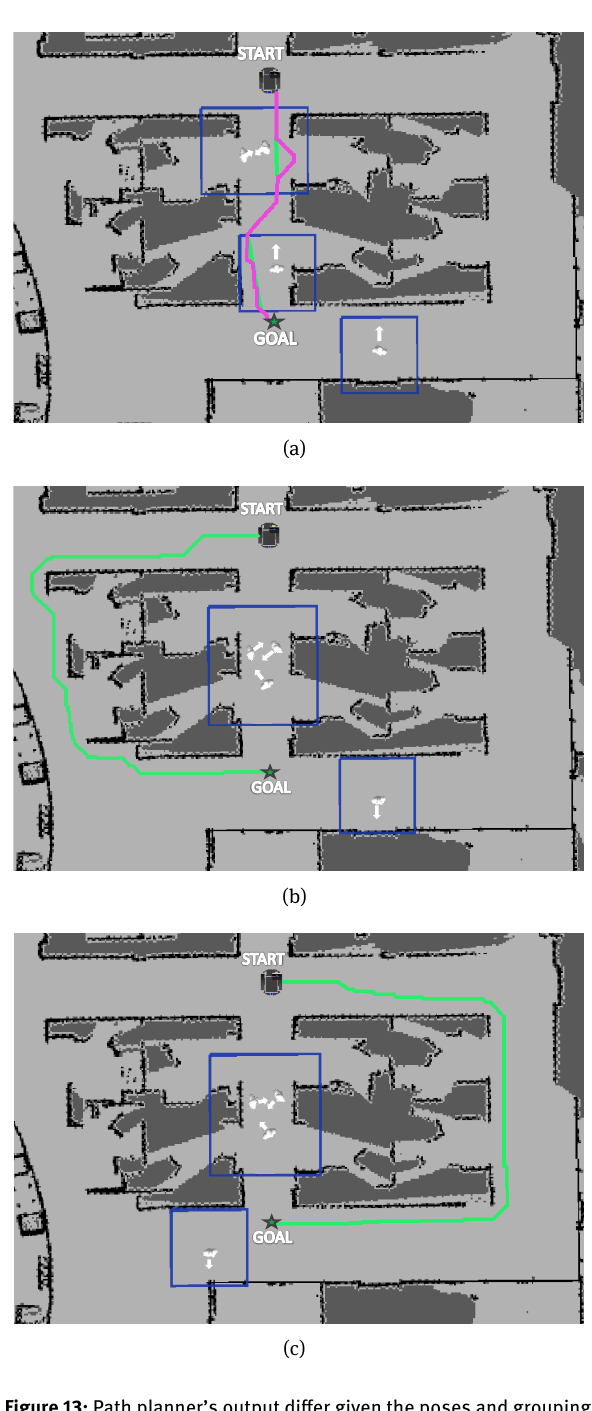
Figure 13: Path planner’s output differ given the poses and grouping of humans. a) The robot takes shortest route, traveling in the vicin- ity of a group of two and another individual; b) third individual joins the group. Robot takes a longer path that doesn’t have humans on path; c) fourth person changes his position, leading the robot to take the longest